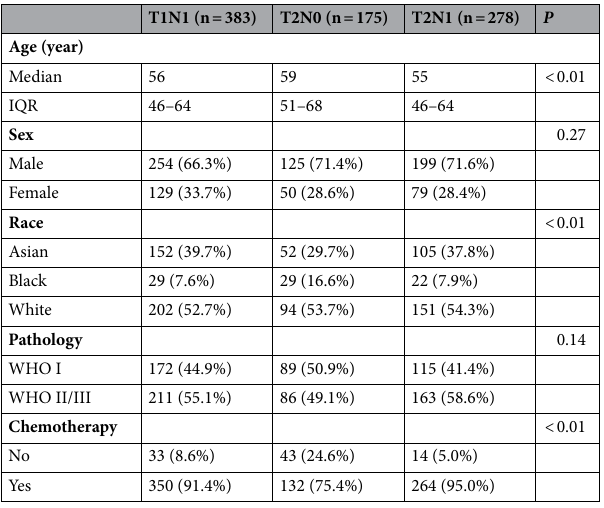
Table 1. Patient characteristics. IQR interquartile range, WHO World Health Organization.